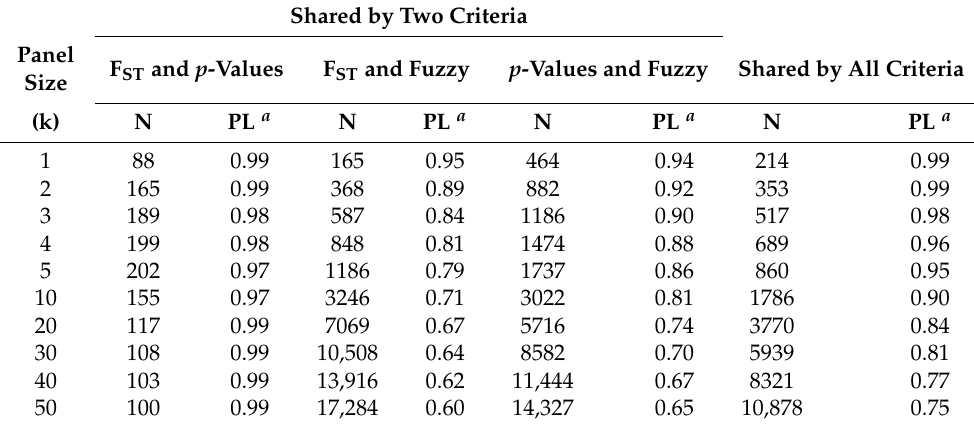
Table 8. The number of shared SNPs and proportion of shared SNPs that are linked with causative variants for F ST score, p -value, and fuzzy score preselection under a genetic architecture of 300 causative variants. Shared by Two Criteria Panel p -Values and Fuzzy